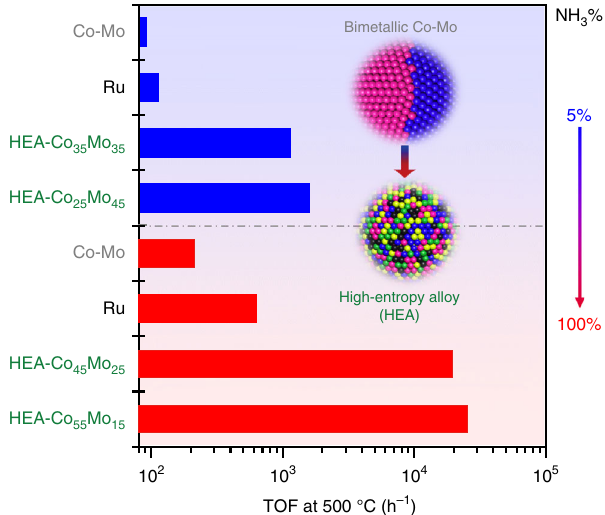
Fig. 7 NH 3 decomposition at different concentrations. The composition of HEA-Co x Mo y catalysts were robustly tuned to optimize the surface properties for different reaction conditions (e.g., 5 vs. 100 vol% NH 3